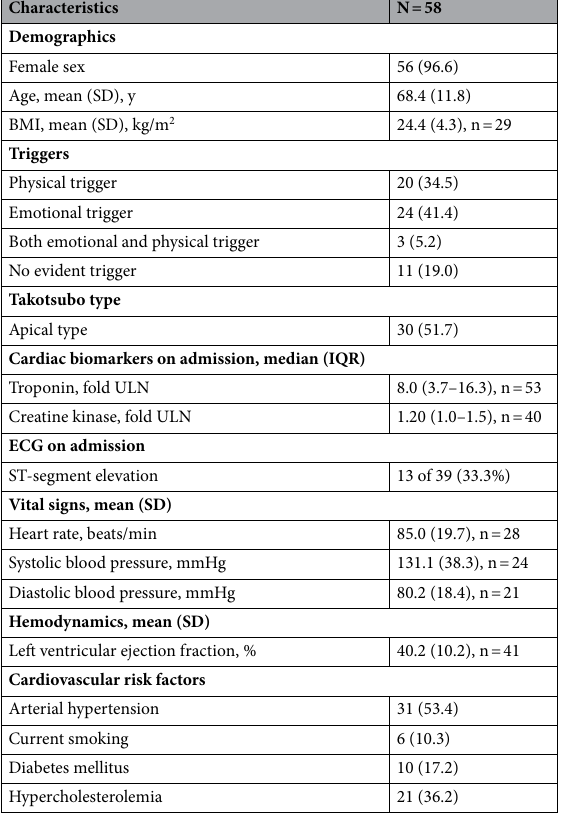
Table 2. Baseline characteristics of patients with takotsubo syndrome. Data are presented as number (percentage) of patients unless otherwise indicated. BMI body mass index, ECG electrocardiogram, IQR interquartile range, SD standard deviation, ULN upper limit of the normal range.